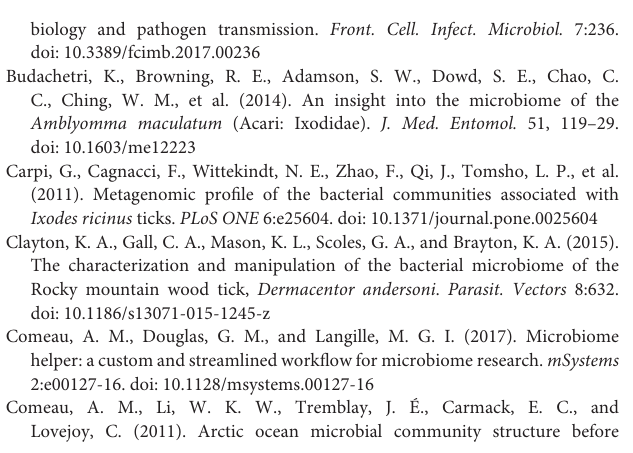
Figure S1 | Quantification of the 16S rDNA gene per the elongation ef-1 α in the midgut (A) and ovary (B) of Ixodes ricinus and in the midgut (C) and ovary (D) of Rhipicephalus microplus during blood feeding on a vertebrate host. MG, midgut; OV, ovary; BF, blood fed; FF, fully fed; AD, after detachment; PEF, partially engorged female; FEF, fully engorged female. Each time-point represents the median of 7 biological replicates for I. ricinus and 6 for R. microplus. Error bars indicate standard deviation. Stars indicate statistically significant differences. ∗ p < 0.05; ∗∗ p < 0.01; and ∗∗∗∗ p < 0.0001. Figure S2 | Negative correlation between 16S rDNA gene in the midgut per the ef-1 α and Ixodes ricinus weight during blood feeding on a vertebrate host. The results represent the median for 7 organs. Spearman’s rank correlation coefficient = − 0.88. Table S1 | Number of good quality 16S rDNA gene sequences obtained through bioinformatic analysis for the analyzed samples. MG, midgut; OV, ovary; BF, blood fed; FF, fully fed; AD, after detachment. Samples in yellow are above both sterility and reliability threshold. Samples in red were removed from the final analysis. Table S2 | Overview of the identified OTUs, and its classification into bacterial phylum and